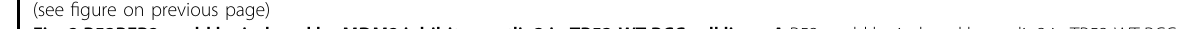
Fig. 2 P53BER2 could be induced by MDM2 inhibitor-nutlin3 in TP53-WT RCC cell lines. A P53 could be induced by nutlin3 in TP53-WT RCC cell lines. B P53BER2 could be induced by nutlin3 in TP53-WT RCC cell lines. C Western blot of H1299 after infected by pLX313-TP53-WT and pLX313- TP53-P278A. D Exogenous P53 but not P53-278A could induce p53BER2 in H1299. E The design and construction of the p53BER2 reporter. F The veri fi cation of p53BER2 reporter in TP53-WT and p53-MUT cell lines. G The dual-luciferase assay showed WT-p53 could induce p53BER2 by binding the p53BER2 promoter. H The relative p53BER2 expression level in 786-0 and H1299-p278A after PRIMA-1-met (37.5 μ M). I Western blot of 786-0 and H1299-p278A after PRIMA-1-met (37.5 uM). EV empty vector. Results are shown as mean ± SD. *** P < 0.001 compared with control. ** P < 0.01 compared with control. * P < 0.05 compared with